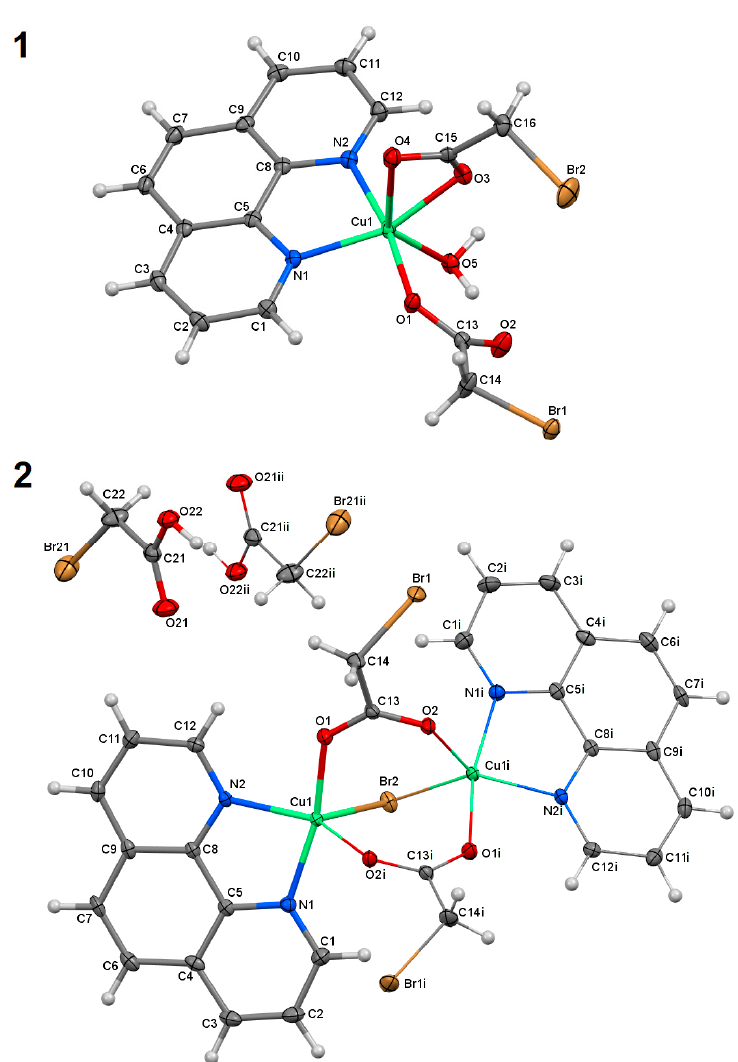
Figure 1. Solid state structures of the studied compounds, with atom numbering scheme, plotted with 50% probability of displacement ellipsoids of non-hydrogen atoms. Hydrogen atoms are plotted as spheres of arbitrary radii. The symmetry generated atoms are indicated by i and ii letters [symmetry code: (i) − x + 1, y, − z + 1.5; (ii) − x + 0.5, − y + 0.5, − z + 1]. The occupancy of hydrogen atom bonded to O22 is set on 0.5 (see Section 3.2).